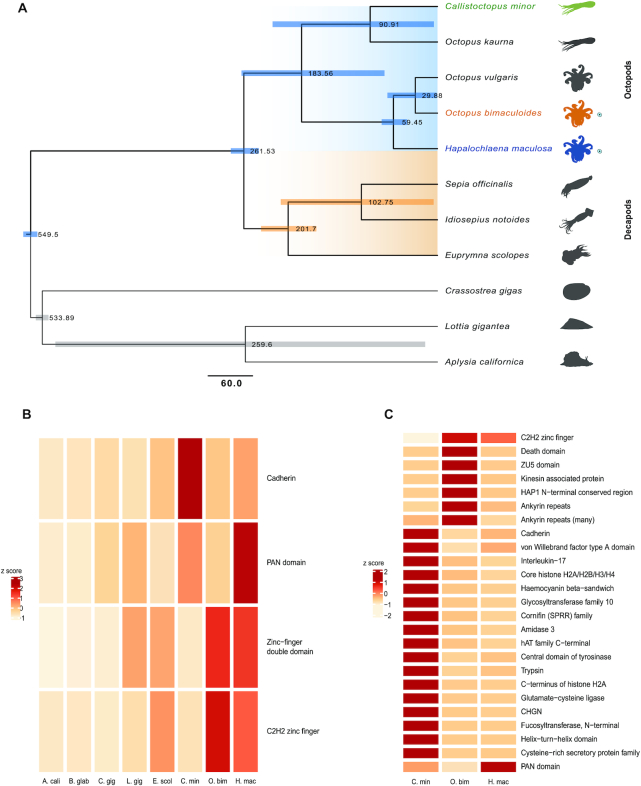
Comparisons of molluscan genomes and gene families. (A) Time-calibrated maximum likelihood phylogeny of 7 molluscan genomes (Aplysia californica, Lottia gigantea, Crassostrea gigas, Euprymna scolopes, Octopus bimaculoides, Callistoctopus minor,andHapalochlaena maculosa) and 4 transcriptomes (Octopus kaurna, Octopus vulgaris, Sepia officinalis, and Idiosepius notoides) using 2,108 single-copy orthologous sequence clusters. Node labels show divergence times in millions of years (mya); blue (divergence to octopods) and orange bars (decapods) represent standard error within a 95% confidence interval. Octopodiformes lineages are highlighted in blue and decapod orange. Scale bar represents mya. (B) Expansions of octopod gene families relative to molluscan genomes Aplysia californica (A. cali), Biomphalaria glabrata (B. glab), C. gigas (C. gig), L. gigantea (L. gig), E. scolopes (E. scol), C. minor (C. min), O. bimaculoides (O. bim), and H. maculosa (H. mac). (C) Lineage-specific gene expansions in the octopod genomes C. minor (C. min), O. bimaculoides (O. bim), and H. maculosa (H. mac). CHGN: chondroitin N-acetylgalactosaminyltransferase; C2H2: Cys2-His2; SPRR: small proline-rich proteins.